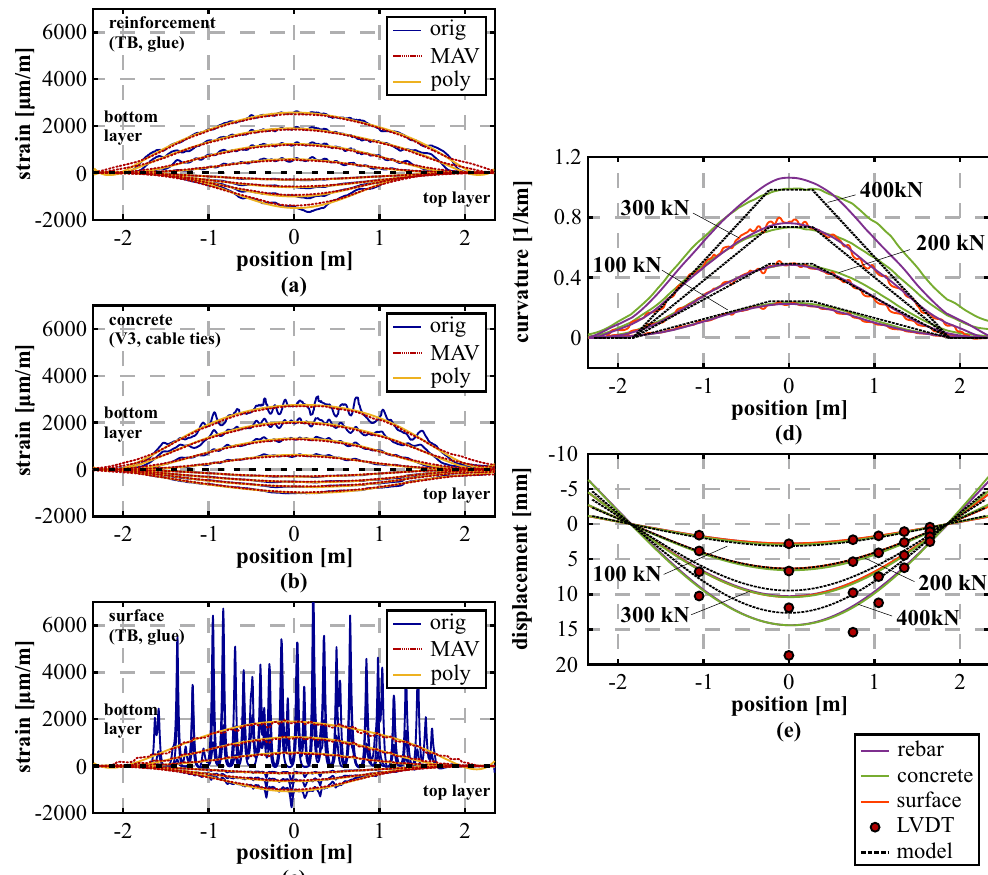
Figure 10. Analysis of different installation techniques: ( a ) Strain profiles along reinforcement (tight-buffered fiber, glue). ( b ) Strain profiles inside concrete (BRUsens V3, cable ties). ( c ) Strain profiles along surface (tight-buffered fiber, glue). ( d ) Curvature values derived from DFOS strains and theoretical model. ( e ) Displacement curves calculated from DFOS strains, measured by LVDT and theoretical